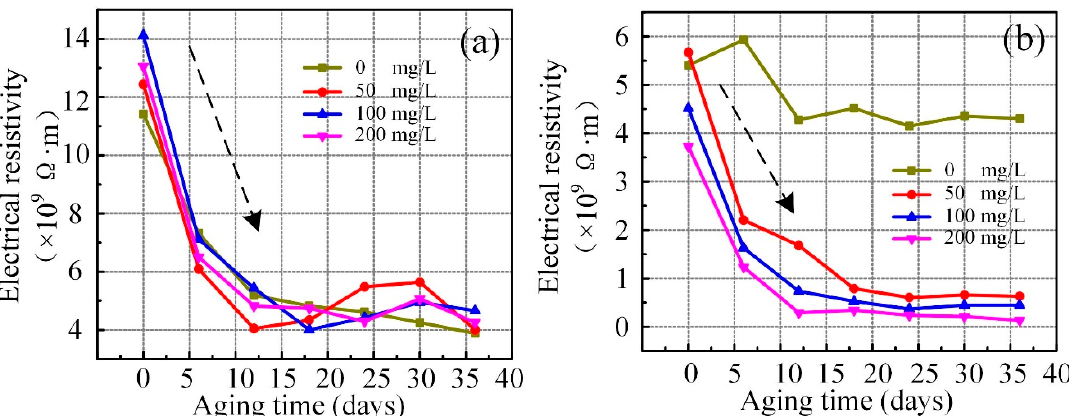
Figure 7. The variation of electrical resistivity with C 60 concentration of aging vegetable insulating liquid ( a ) and aging mineral liquid ( b ).